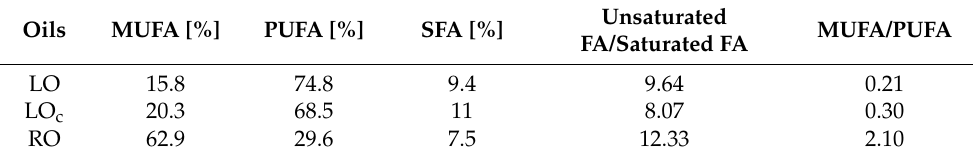
Table 1. Fatty acid (FA) composition of the three oils used: total levels of MUFA, PUFA and SFA [%] and the ratio of unsaturated fatty acids to saturated fatty acids and MUFA to PUFA.